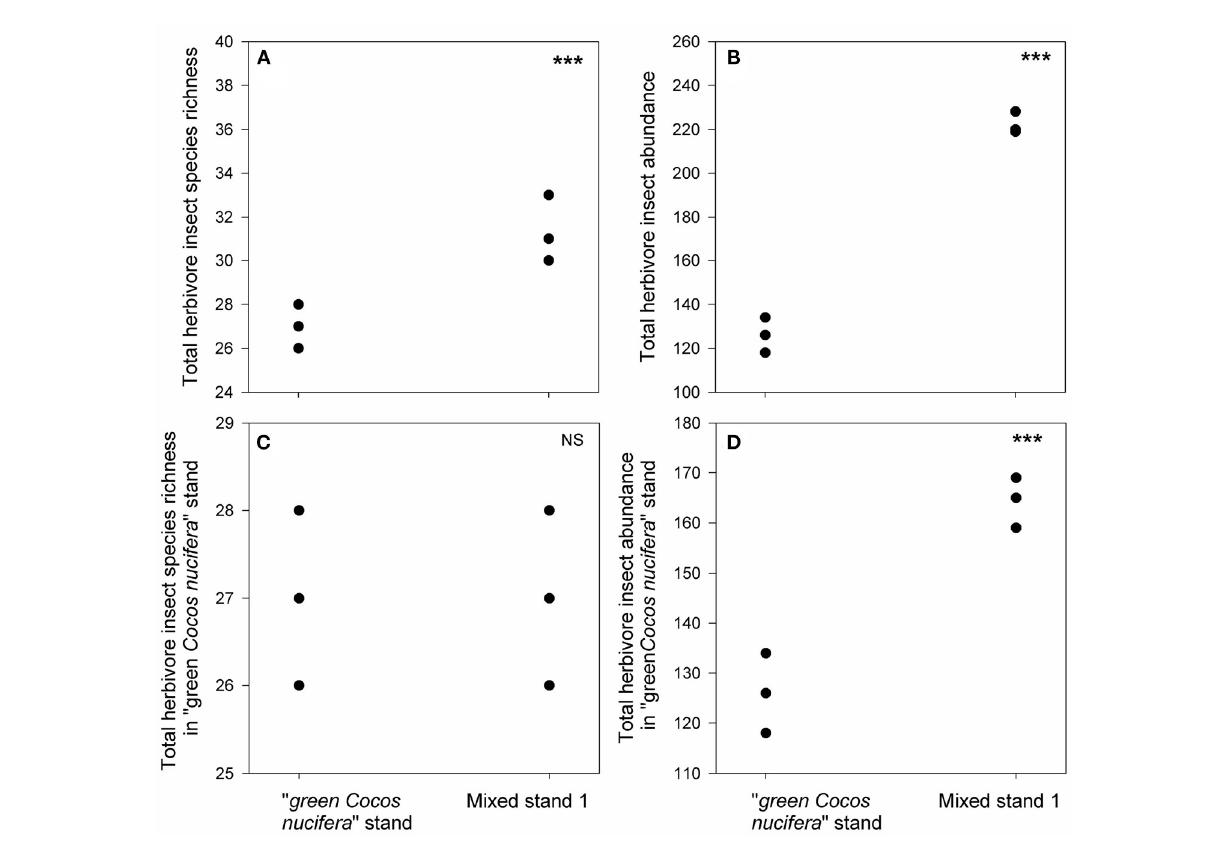
FIGURE3 Differences in total herbivore insect species richness (A) , total herbivore insect abundance (B) , total herbivore insect species richness in “green Cocos nucifera ” stand (C) and their abundance (D) between mixed stand 1 and “green Cocos nucifera ” stand. *** indicates p < 0.05, results from our generalized linear mixed effect model with Poisson